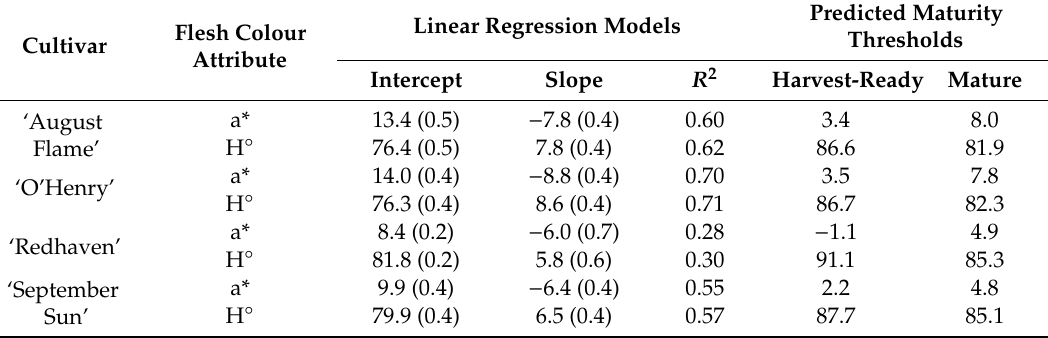
Table 3. Linear regression models and predicted thresholds ( y ) of flesh a* and H ◦ for the maturity classes “harvest-ready” and “mature” based on the indices of absorbance di ff erence ( x ) reported in Table 1. Data reported for fruit of four yellow peach cultivars at harvest ( n = 200). Intercept, slope and coe ffi cients of determination ( R 2 ) reported for each linear regression model. Standard errors of intercept and slopes are in brackets.